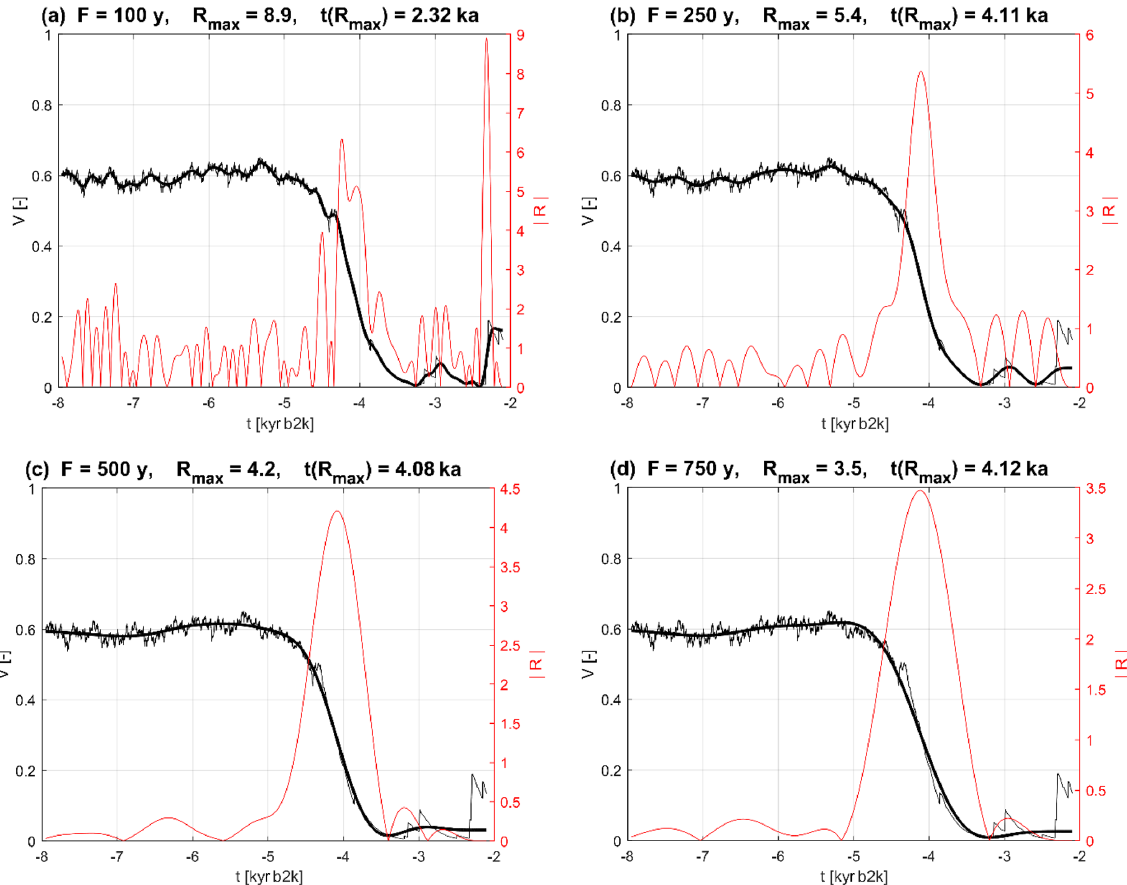
Figure C1. Effect of filtering on R max . Black lines indicate fractional coverage of extratropical deciduous trees in a grid box in East Siberia centred at 62.48 ◦ N, 120 ◦ E, in region 2 (see Figs. 12 and 13a) as function of time (in ka). The thin lines are annual values of fractional vegetation coverage V ( t ), and the thick lines are filtered time series of V ( t ) using a Butterworth filter of the order of 5 with a low-pass filter of (a) F of 100 years, (b) F of 250 years, (c) F of 500 years, (d) F of 750 years. The absolute value of the relative change R is shown as a dotted red line. The titles of each subfigure indicate the strength of the low-pass filter F , the maximum of the absolute value of the relative change R max and the time t at which R max